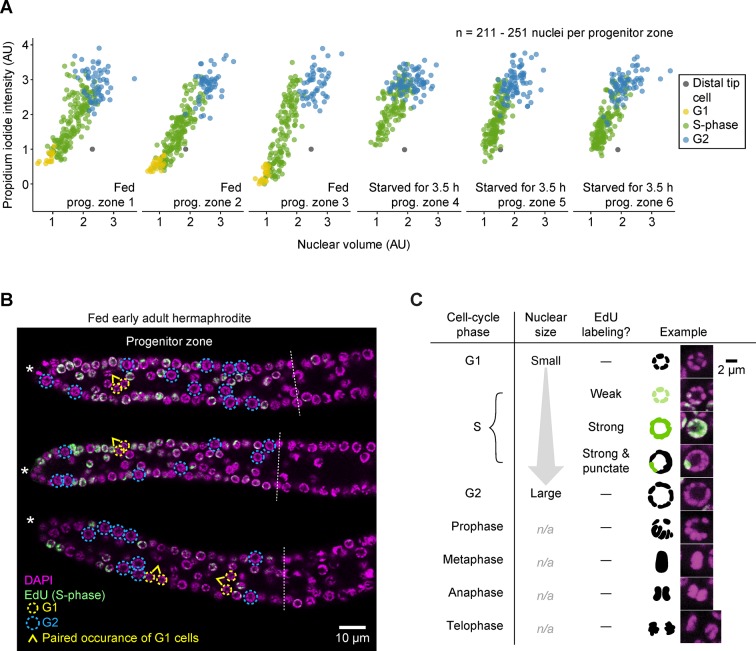
G1 versus G2 cells can be distinguished by nuclear size in EdU-labeled gonads.(A) Propidium iodide intensities (a measure of DNA content) versus nuclear volume for interphase progenitor-zone nuclei and the distal tip cell nucleus in six gonadal arms. Propidium iodide intensities are scaled relative to the distal tip cell and the mean of G2 cells, to account for gonad-to-gonad differences in staining. Left, fed early adult hermaphrodites. Right, hermaphrodites starved from early adult for 3.5 hr. Cell-cycle phases were assigned by EdU uptake (S-phase cells) and nuclear size (G1 versus G2). AU, arbitrary units. (B) Images of EdU-labeled distal gonads (15 min EdU pulse) dissected from fed early adult hermaphrodites and stained with DAPI to visualize DNA (magenta). Asterisks, distal gonad ends. Dashed lines, progenitor zone boundaries. Yellow and blue circles, examples of G1 and G2 nuclei, respectively. Caret, paired occurrence of G1 cells. (C) Images of progenitor-zone nuclei in each stage of the cell cycle. Nuclei derive from gonads described as in B. n/a, not applicable. Source data are available in Figure 3—source data 4DOI: